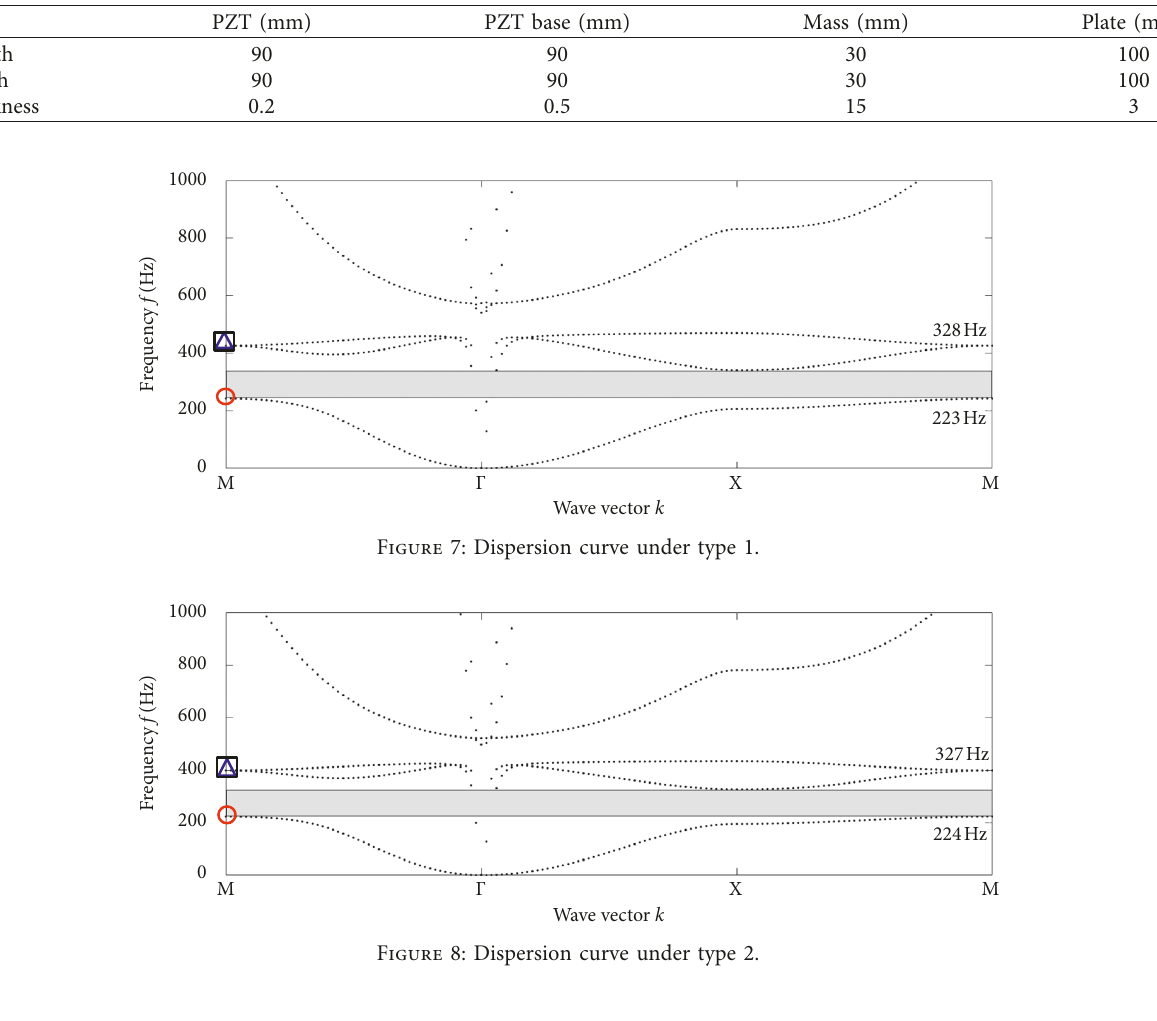
Figure 6: Four candidate configurations of the local resonator. (a) Type 1. (b) Type 2. (c) Type 3. (d) Type 4. Table 2: Geometric dimensions of the unit cell in simulations.